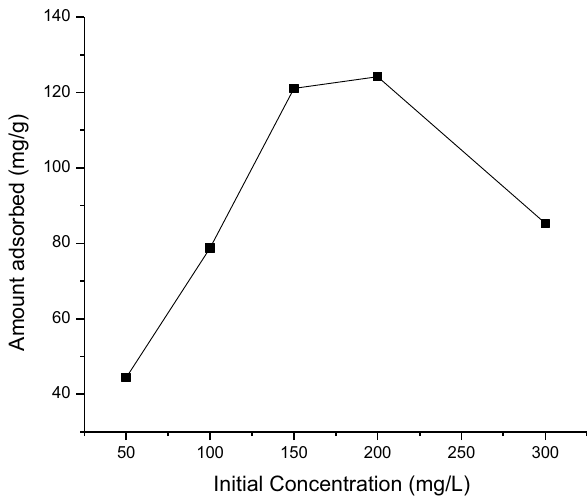
Fig. 7 Effect of initial pollutant concentration on adsorption of Pb 2+ ions on WM-Fe 3 O 4